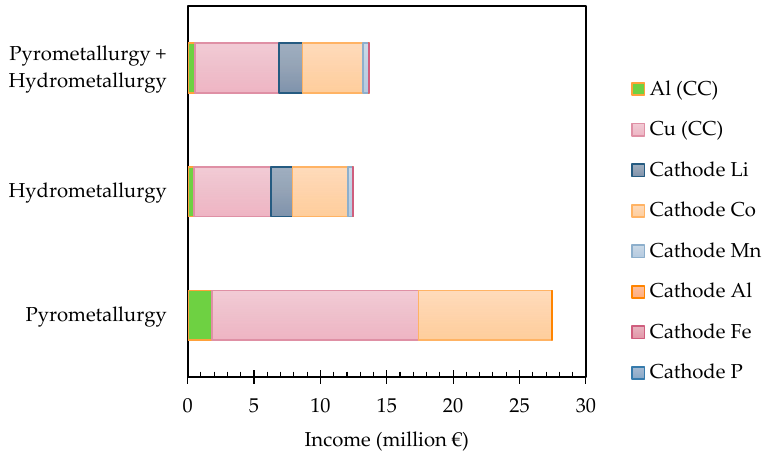
Figure 4. Potential incomes (million €) associated with the market value of the secondary raw materials involved by LIBs’ recycling in 2030 (CC: current collector) .